Question: Name the type of graph shown.
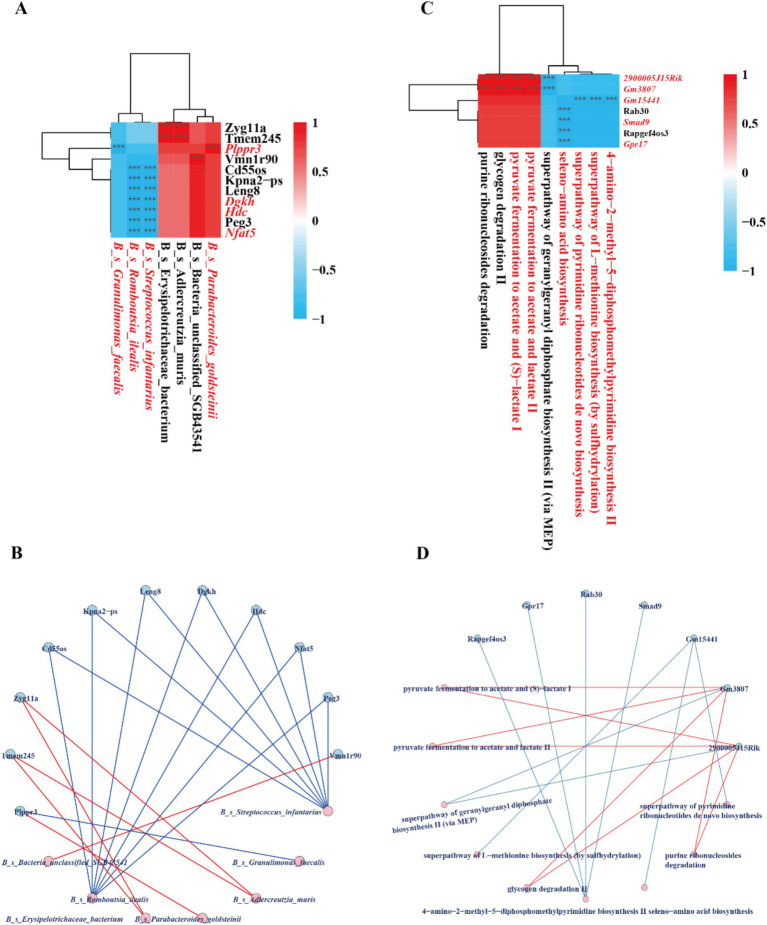
Answer: heatmap